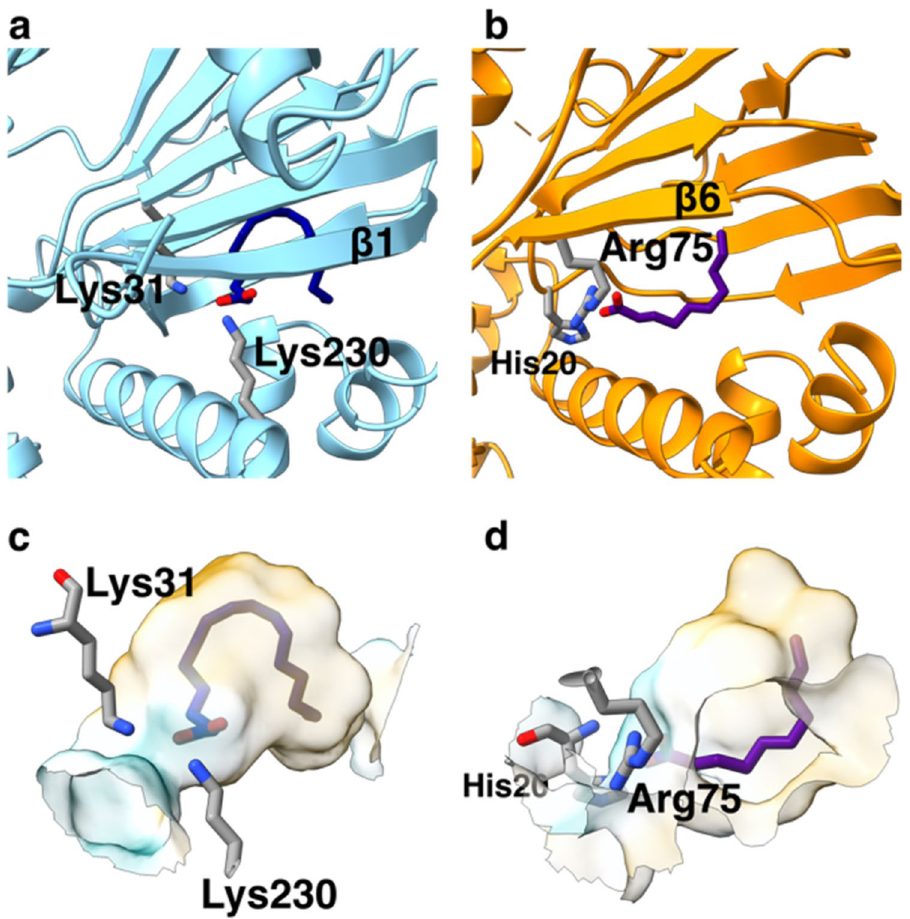
Figure 7. Comparison of the binding pockets of ToxT and Rns. ( a ) ToxT in blue with the palmitoleic acid in dark blue. ( b ) The native Rns in orange with the decanoic acid in purple were aligned in ChimeraX 38 using the long helix in the DBD. The β-strand for each protein closest to the long helix in the DBD are labeled, as well as the residues which make contacts with the fatty acids. The binding pockets for ( c ) ToxT and ( d ) Rns are shown. The surfaces are colored according to lipophilicity calculated using ChimeraX 38 , with cyan for charged areas and orange for hydrophobic surfaces. Again, the residues interacting with fatty acids are labeled. Images created with ChimeraX 38